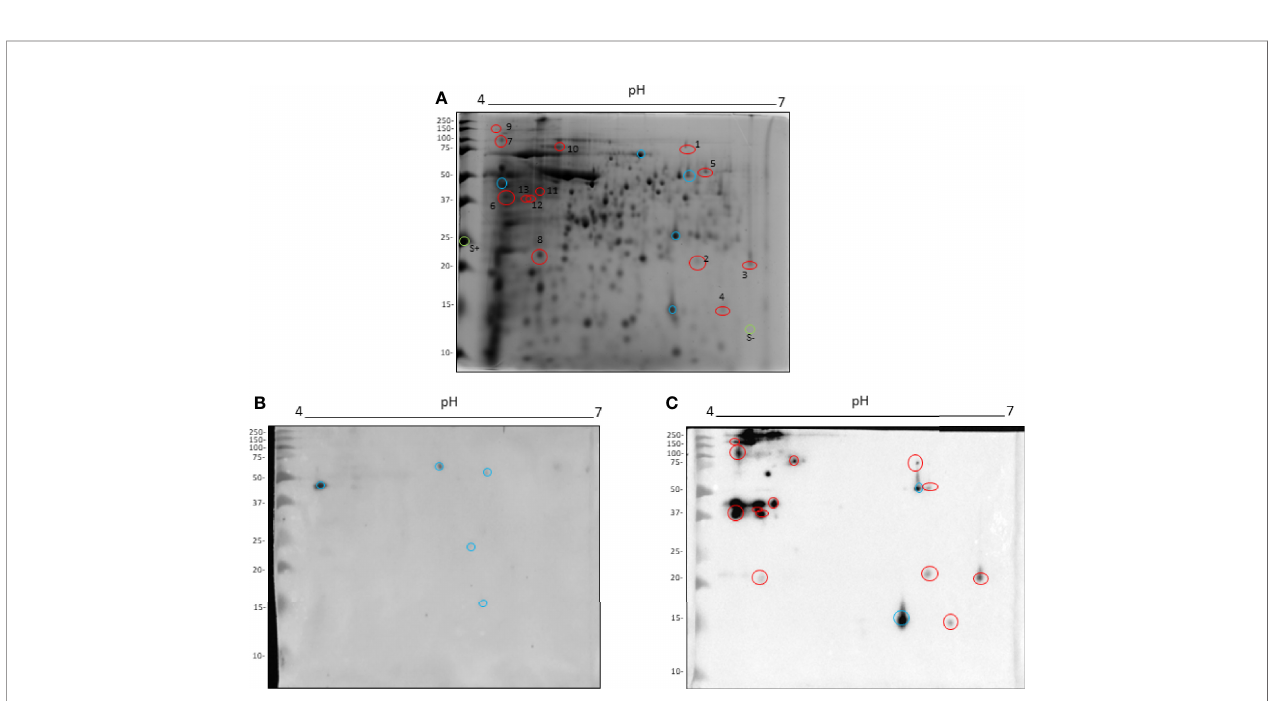
FIGURE 3 | Immunoproteomic analysis by 2D Western blot. Total L. amazonensis proteins distributed in a 2D SDS-PAGE stained with Comassie Brillant Blue (A) . Membrane of 2D Western blot incubated with a pool of serum from the PBS control mice (B) . Membrane of 2D Western blot incubated with a pool of serum from mice immunized with TLA + Poly (I:C) + Montanide ISA 763 (C) . Blue circles represent spots recognized by the PBS control serum. Red circles represent spots analyzed by mass spectrometry. Green circles represent negative and positive controls of protein in